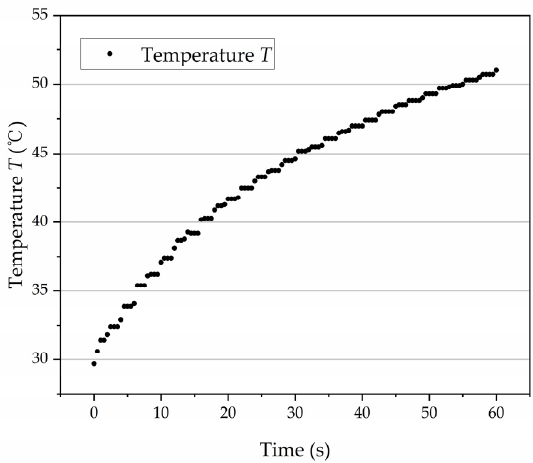
Figure 14. Temperature changes with time at 15,000 rpm.